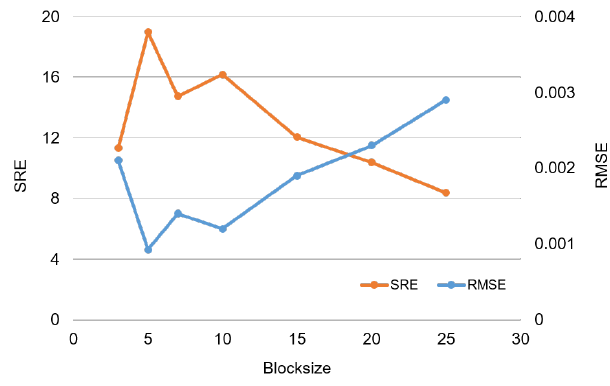
Figure 13. RMSE and SRE in relation to block